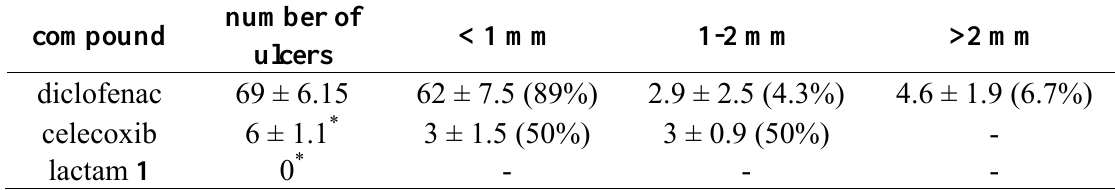
Table 2. Ulcerogenic effect of diclofenac, celecoxib and lactam ( 1 ) in rats (n = 6, mean ±S.D.). compound